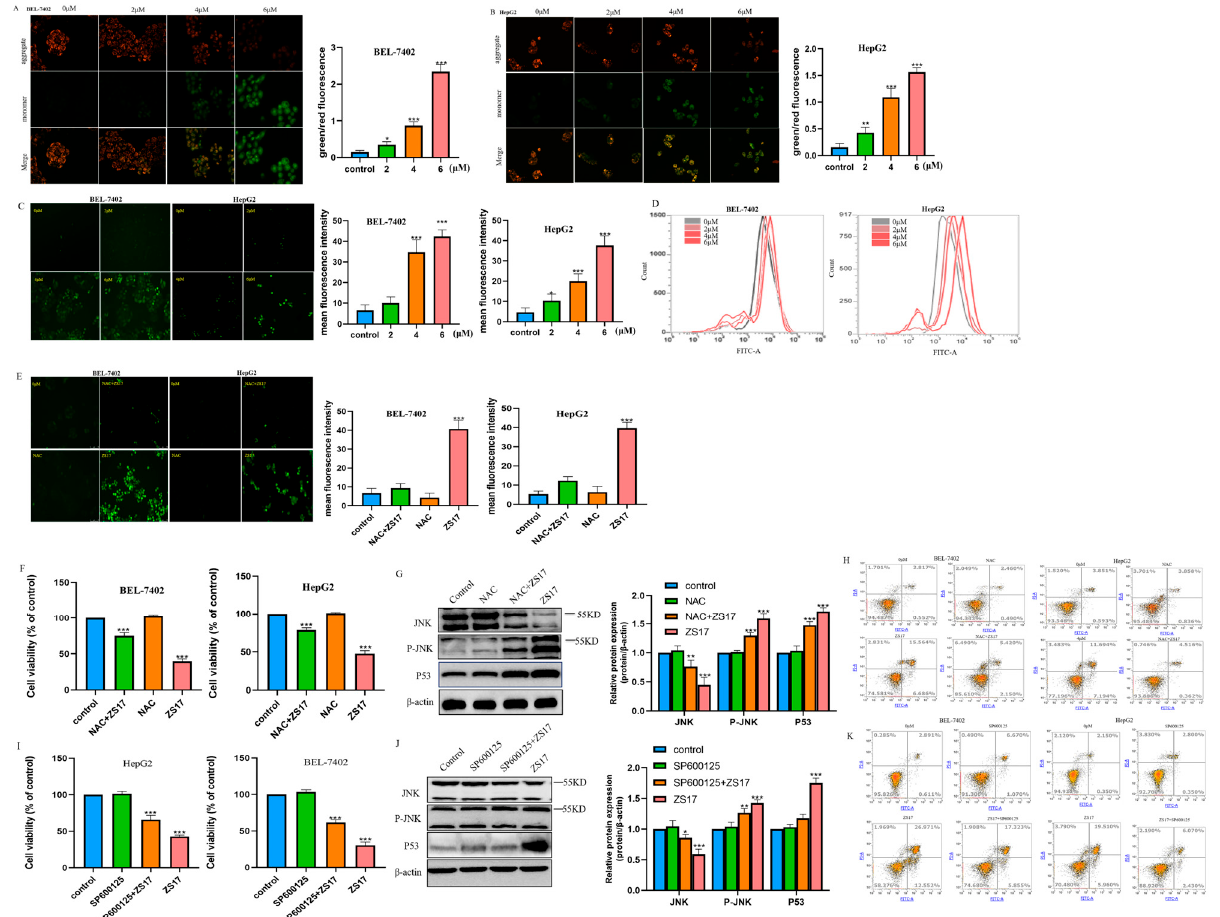
Figure 6. ZS17 induces ROS generation and NAC inhibits ROS generation, attenuating ZS17 -mediated apoptosis. ( A , B ) The mitochondrial membrane potential (MMP) was detected by a fluorescence microscope using JC-1 probe staining. ( C ) ROS generation was observed by fluorescence microscopy using a DCFH-DA probe. ( D ) ROS detection with DCFH-DA dye in different groups by flow cytometry. ( E ) BEL-7402 and HepG2 cells were pre-treated with NAC (5 mM, 1 h) and post- treated with ZS17 (5 mM) for 24 h, and ROS generation was observed by fluorescence microscopy using DCFH-DA probe staining. ( F , I ) Cell proliferation ability was detected by MTT assay. ( G ) The expression of JNK and p-JNK in HepG2 cells treated with NAC, ZS17 , and NAC + ZS17 were detected by western blot. ( J ) The expression of JNK and p-JNK in HepG2 cells treated with NAC, ZS17 , and NAC + ZS17 was detected by western blot. ( H , K ) Apoptosis was detected by AnnexinV-FITC/PI staining and flow cytometry. Microscope’s magnification is 40 × . Data are expressed as mean ± SD. Compared with model group: * p < 0.5, ** p < 0.01, *** p < 0.001. n = 3 per